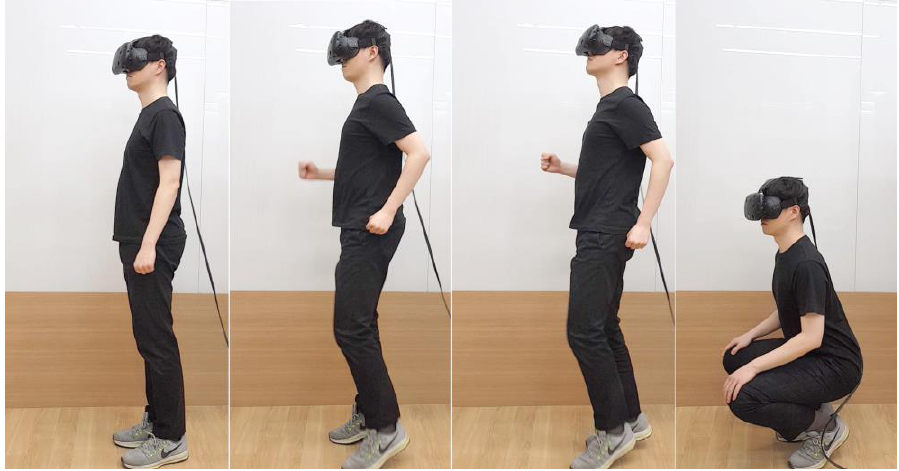
Figure 14. The order in which the evaluation occurred. From left to right: calibration, task 1 (forward navigation), task 2 (backward navigation), and task 3 (squat).